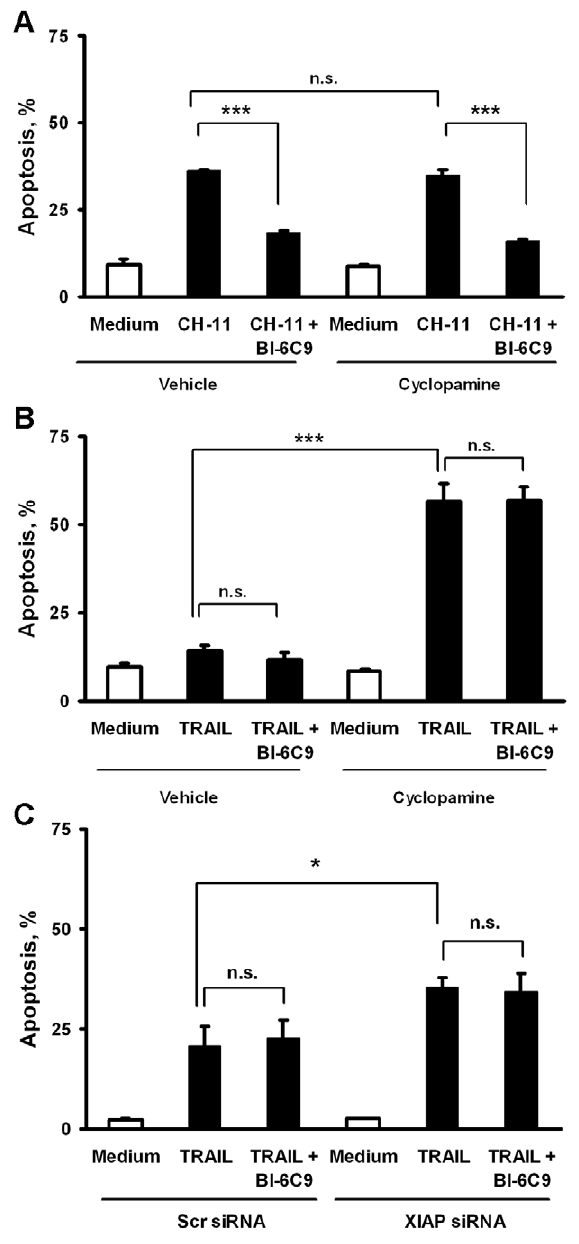
Figure 6. XIAP knockdown sensitizes cells to TRAIL-induced cell death despite Bid inhibition. A, KMCH cells were incubated